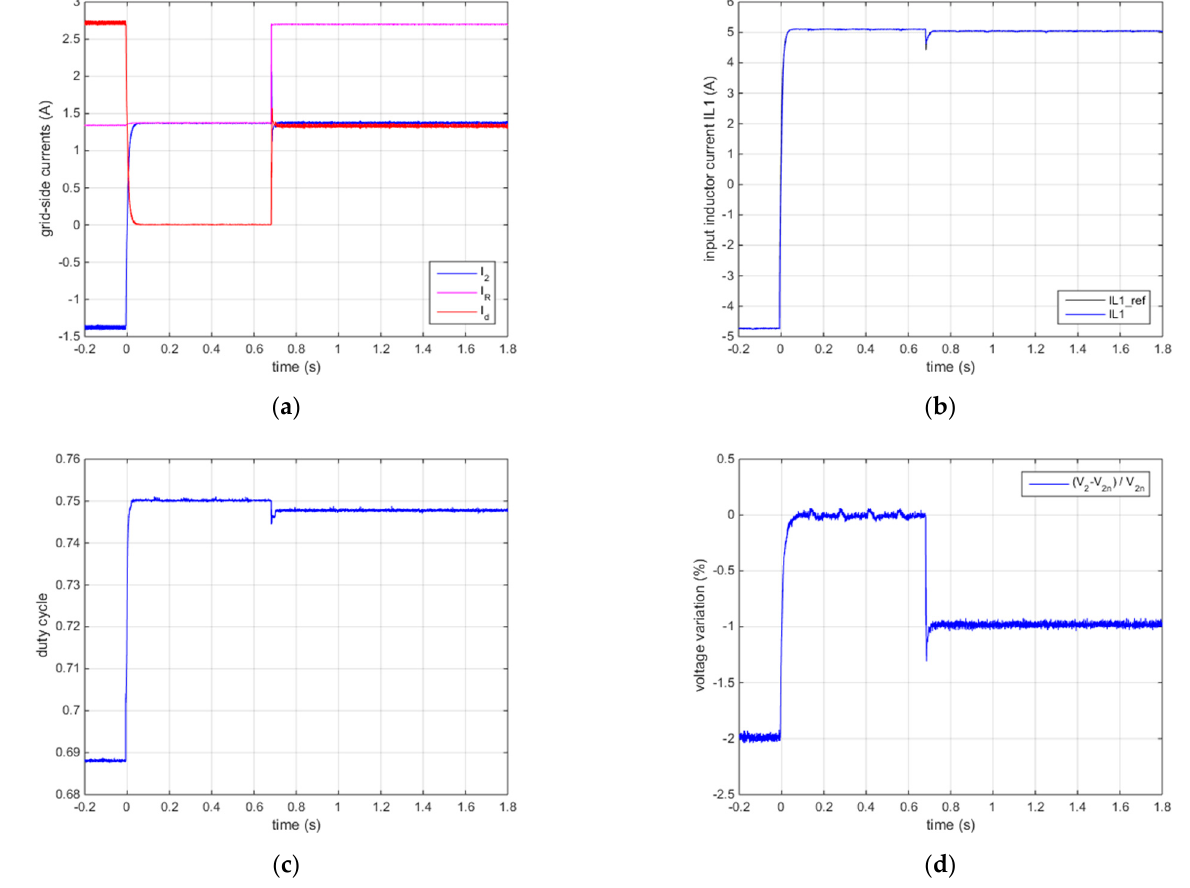
Figure 13. Experimental results in scenario #4 (SC − GD): ( a ) grid − side currents; ( b ) input inductor current; ( c ) duty cycle; ( d ) percentage variation of microgrid voltage.